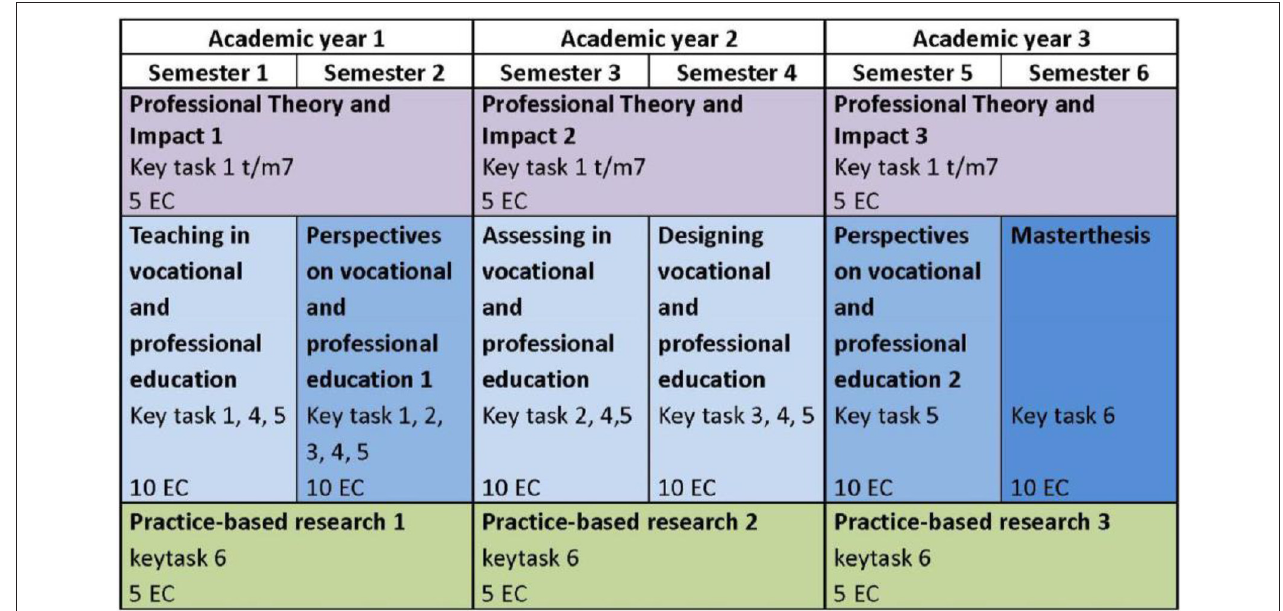
FIGURE 1 | Master’s Expert Teacher of Vocational Education